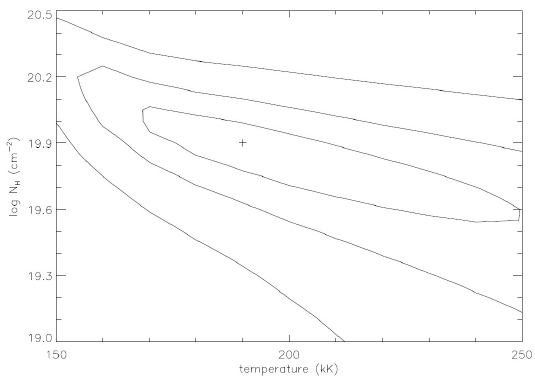
Figure 4: Position of the best-fit model in the T eff –log N H parameter plane and contours of χ 2 = [1 . 5 , 3 , 6] χ 2 min